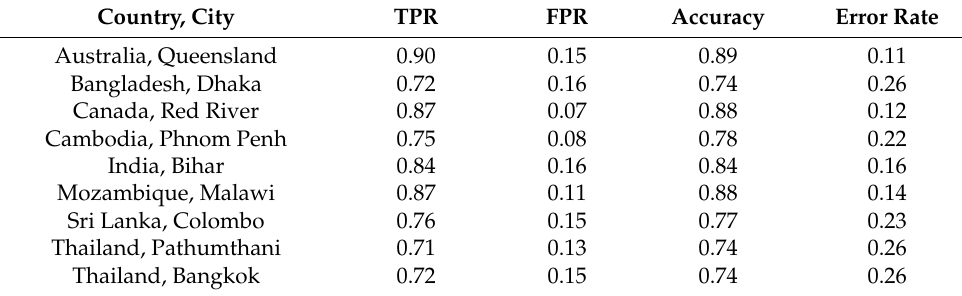
Table 5. FMA performance metrics for flood